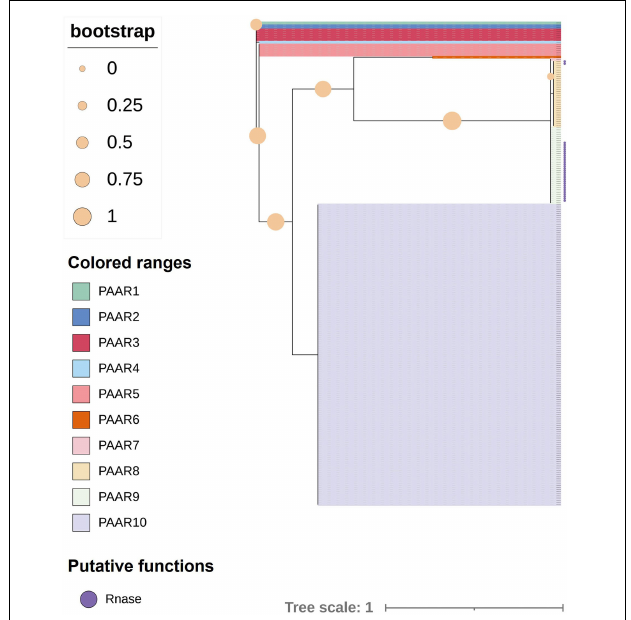
FIGURE 8 | Phylogenetic tree of proline–alanine–alanine–arginine (PAAR) proteins in 226 strains of K. pneumoniae . The tree was generated from PAAR amino acid sequences of intact T6SS clusters using FastTree. Filled circles at nodes indicate bootstrap values. Groups 1–10 represent different PAAR proteins with different colors. Purple circles indicate PAAR proteins with a bacterial toxin 44 domain at the